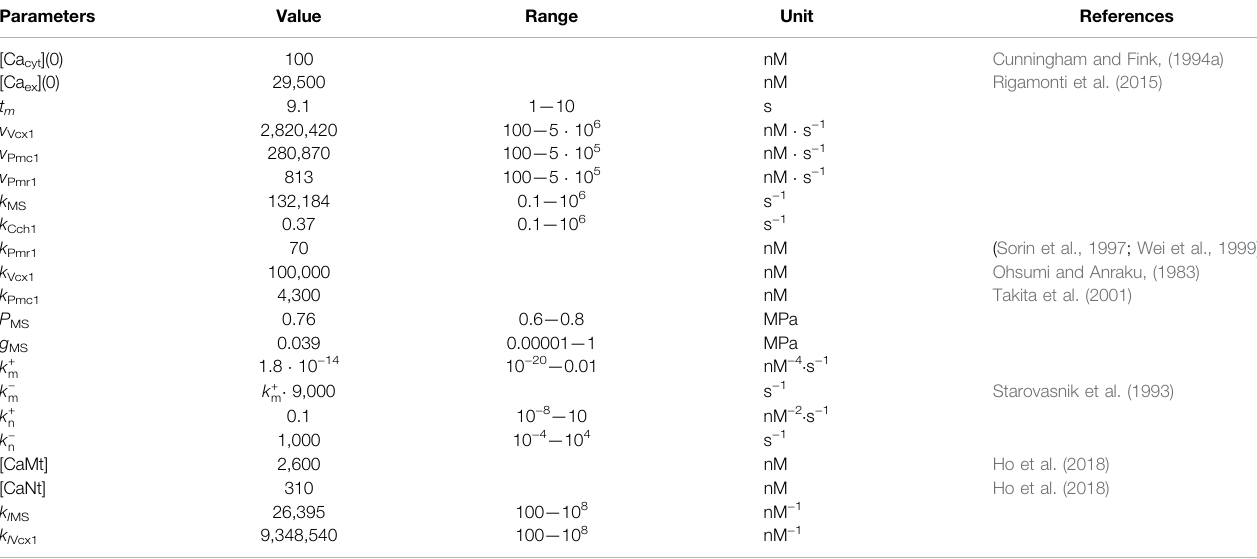
Known parameters were fi xed, while parameters that needed to be estimated were allowed to change inside the values shown in the “ Range ” column. Simulations of the mutant strains were done with the parameters listed here, except for those listed in Table 3 .